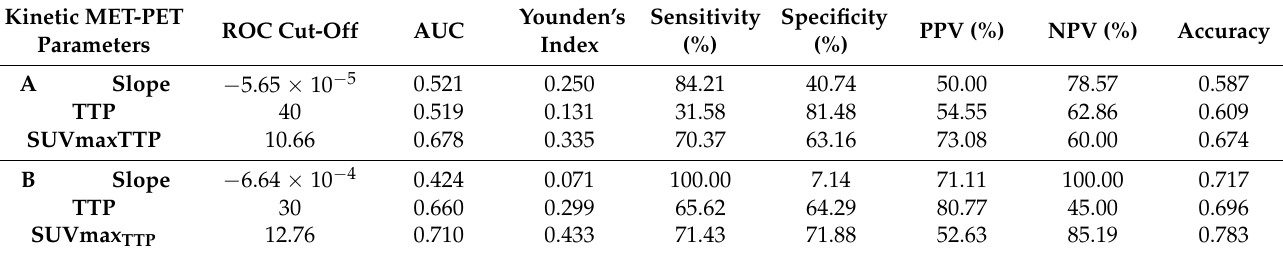
Table 6. Diagnostic performance of kinetic MET-PET parameters assessed by additional receiver operating characteristic curve analysis using (A) progression-free survival at 6 months and (B) OS at 1 year as reference. Kinetic MET-PET